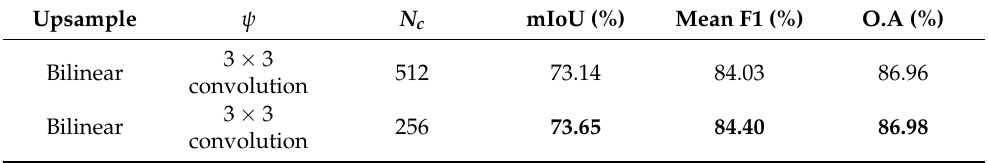
Table 5. The effect of different feature channels, N c , in the decoder network using the UDD-6 dataset.